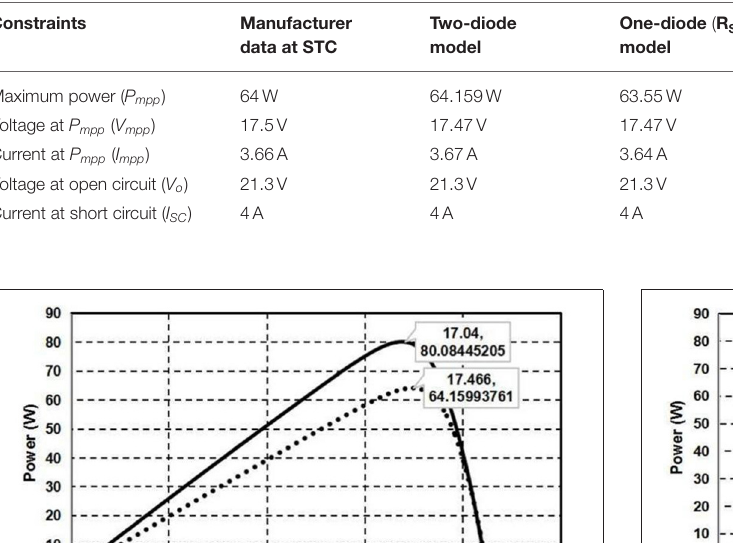
TABLE 5 | Comparison of estimated values at maximum power ( P mpp ) of the two-diode model and one-diode ( R SH ) model for a poly-crystalline solar cell (MSX-64).